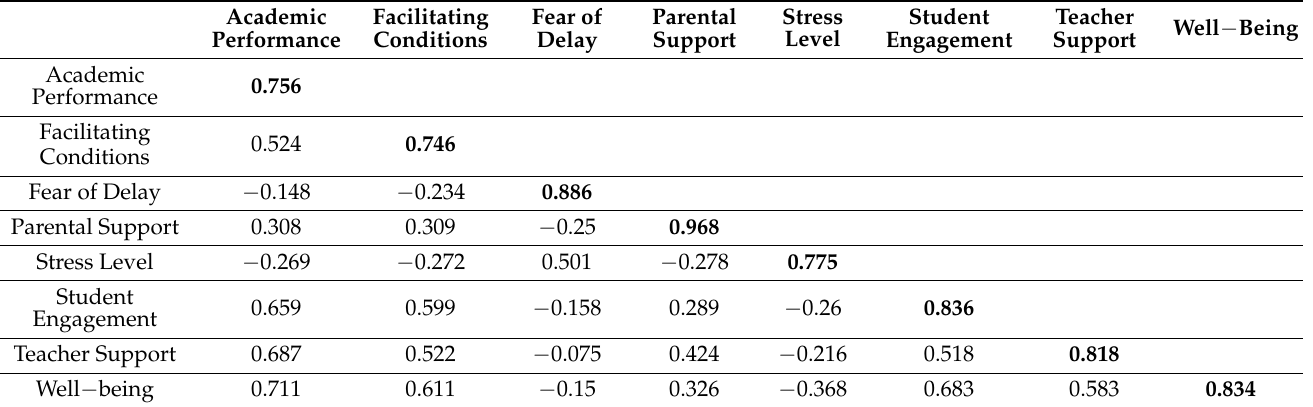
Table 4. Results of the Fornell–Larcker test for assessing discriminant validity.